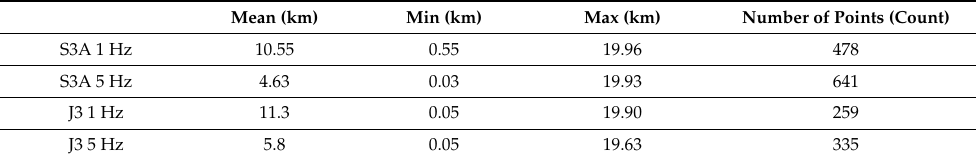
Table 4. Statistics of distance to the coast for the closest altimeter point with a minimal availability rate of 80%. Statistics computed for S3A and J3 measurements retrieved in the 1 Hz and 5 Hz products over the European coasts.